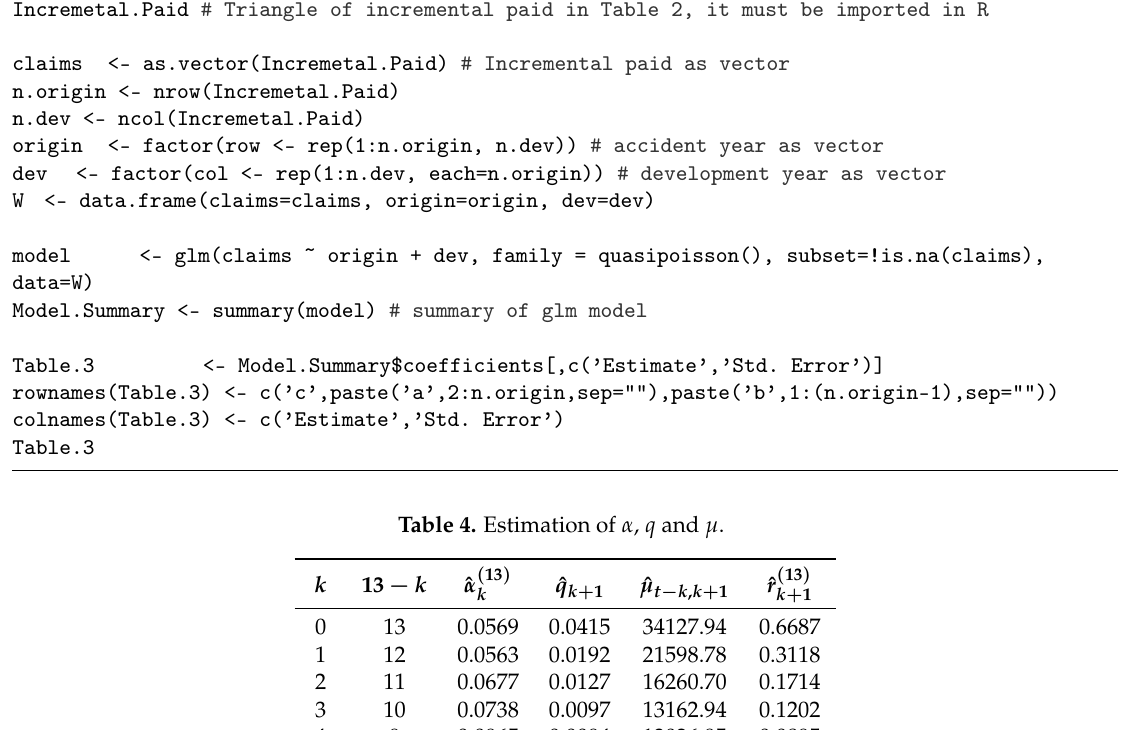
Listing 1. Code for Table 3: Estimation GLM parameters.